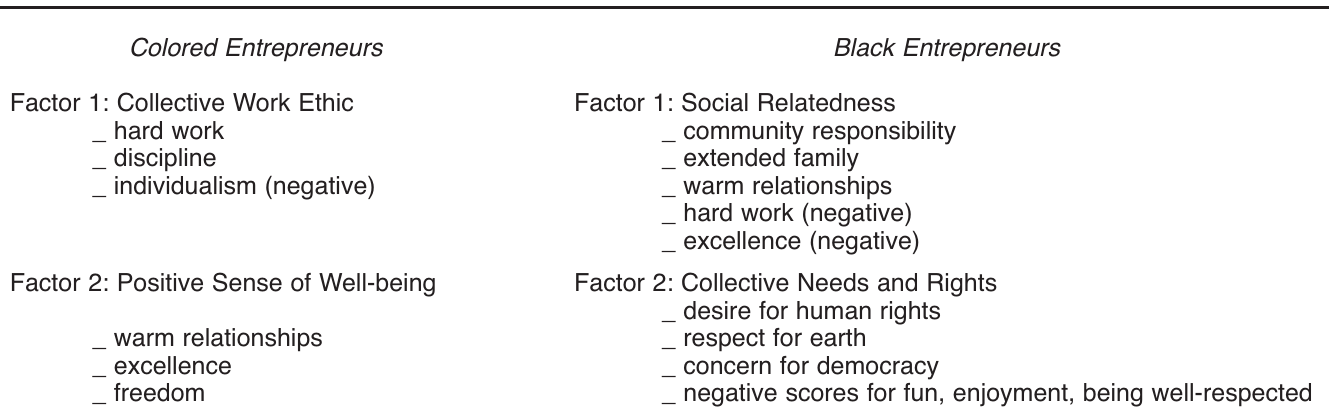
Differences Between Ethnic Groups Based on Factor Analysis of 26